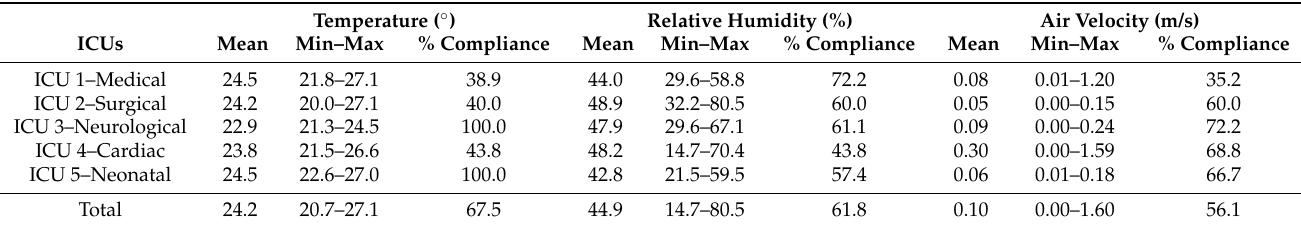
Table 6. Mean values of temperature, relative humidity, and air velocity and % of compliant samples by parameter and